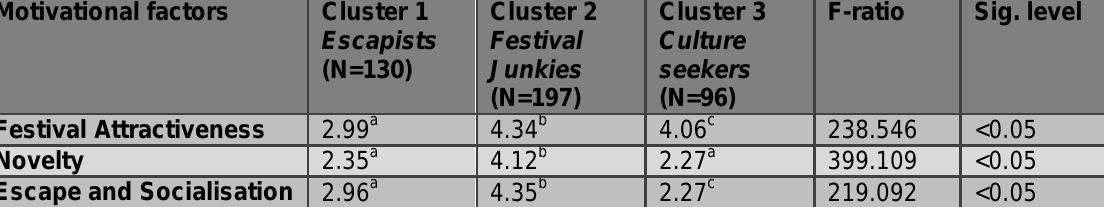
Table 3: ANOV A and Tukey’s post hoc multiple comparison results for motivational factors in three clusters of KKNK visitors Motivational